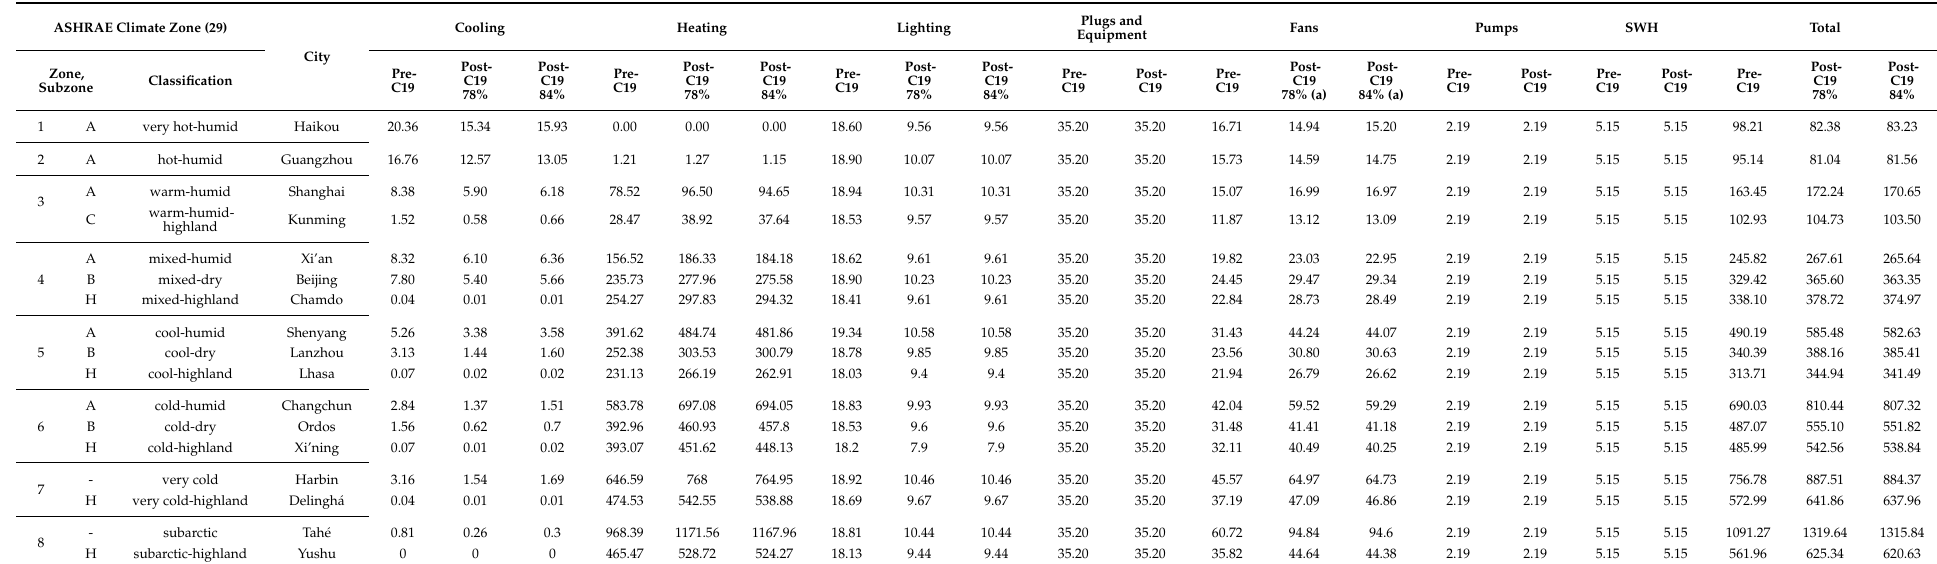
Table A3. Pre-and post-C19 scenario EUI results by location in kWh/m 2